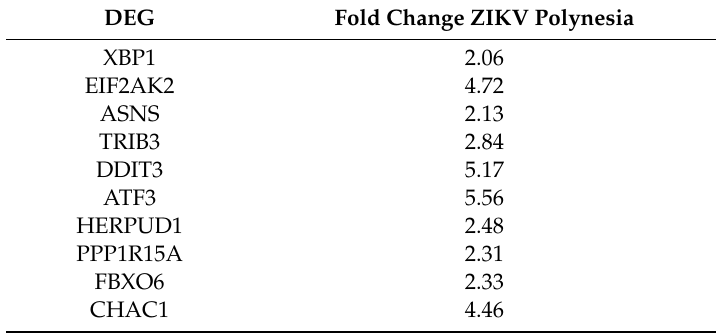
Table 6. Di ff erentially expressed genes (DEGs) during infection with ZIKV Polynesia at 72 hpi, which were annotated to GO-term ”response to endoplasmic reticulum stress”.